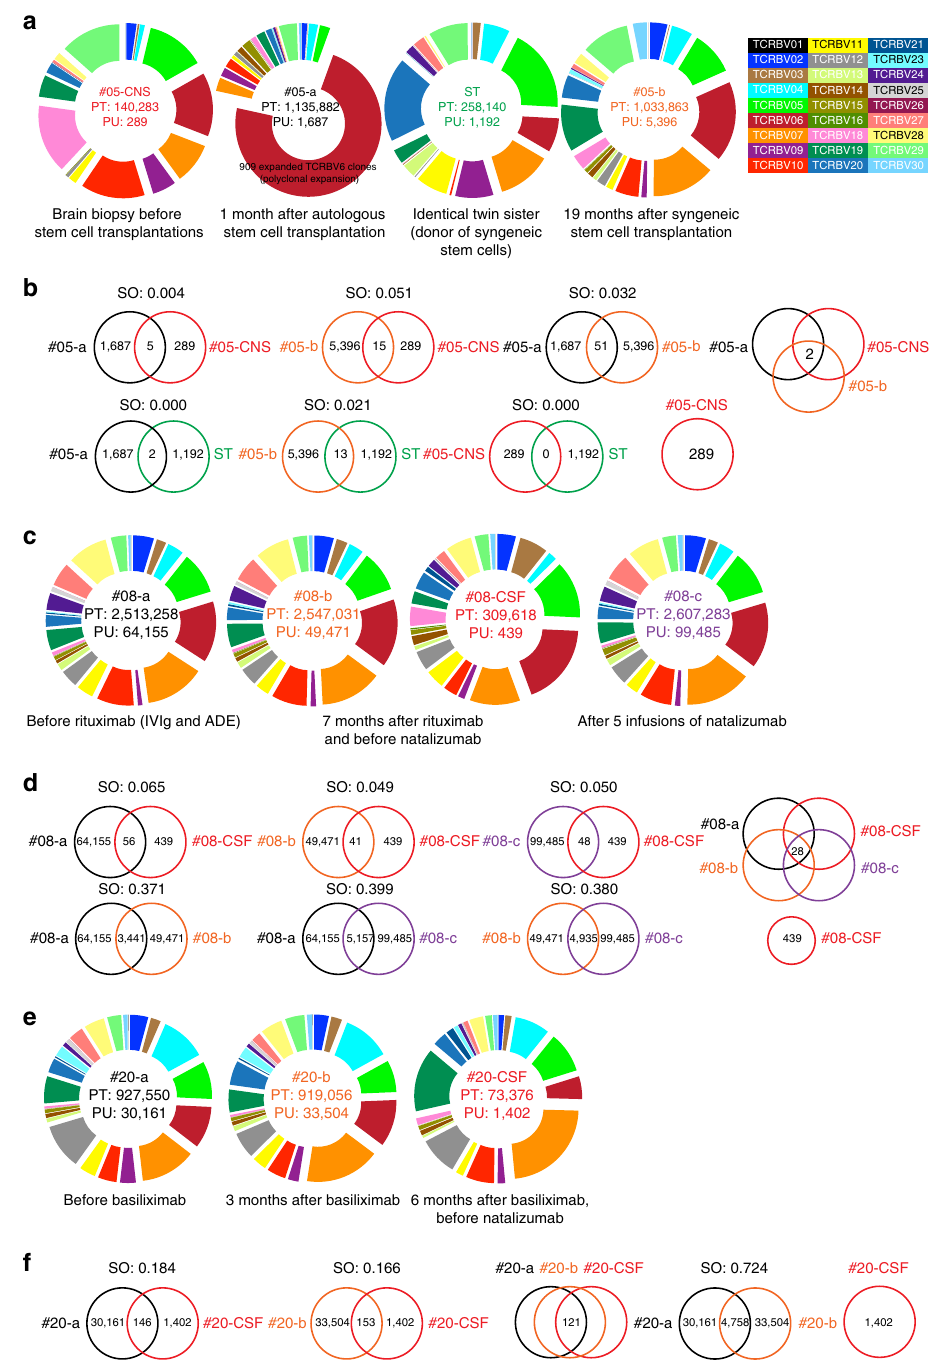
Figure 5 | Experimental therapies for RE. ( a ) Shown are the V b family distribution in a CNS sample before the stem cell transplantations (red), in a peripheral CD8 þ T-cell sample 1 month after the autologous stem cell transplantation (black), in the syngenic twin sister (ST; green) and in a peripheral CD8 þ T-cell sample 19 months after the syngeneic stem cell transplantation (orange). Given are PTand PU. ( b ) Given are the SOs between the different samples and the productive uniques, as well as shared clonotypes (in the Venn diagrams). Listed are the shared clonotypes (amino-acid sequence, V b and J b genes, frequency in either peripheral samples (peri.) or the CNS. ( c ) Shown are the V b family distribution in a peripheral CD8 þ T-cell sample before rituximab (black), 7 months after rituximab treatment and before treatment with natalizumab (orange), after 5 infusions of natalizumab (purple), and in a CSF sample after treatment with rituximab and before treatment with natalizumab (red). Given are PTand PU, as well as the top 10 CDR3 sequences of the CSF sample. ( d ) Given are the SO between the different samples and the productive uniques, as well as shared clonotypes (in the Venn diagrams). Listed are the shared clonotypes (amino-acid sequence, V b and J b genes, frequency in either peripheral samples (peri.) or the CSF. ( e ) Shown are the V b family distribution in a peripheral CD8 þ T-cell sample before basiliximab (black), 3 months after basiliximab treatment and before treatment with natalizumab (orange), and in a CSF sample 6 months after treatment with basiliximab and before treatment with natalizumab (red). Given are PTand PU. ( f ) Given are the SO between the different samples and the productive uniques, as well as shared clonotypes (in the Venn diagrams).